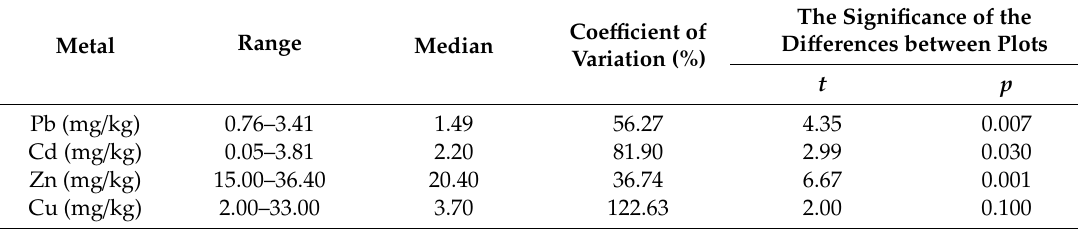
Table 5. Statistical data on heavy metal content in polyfloral